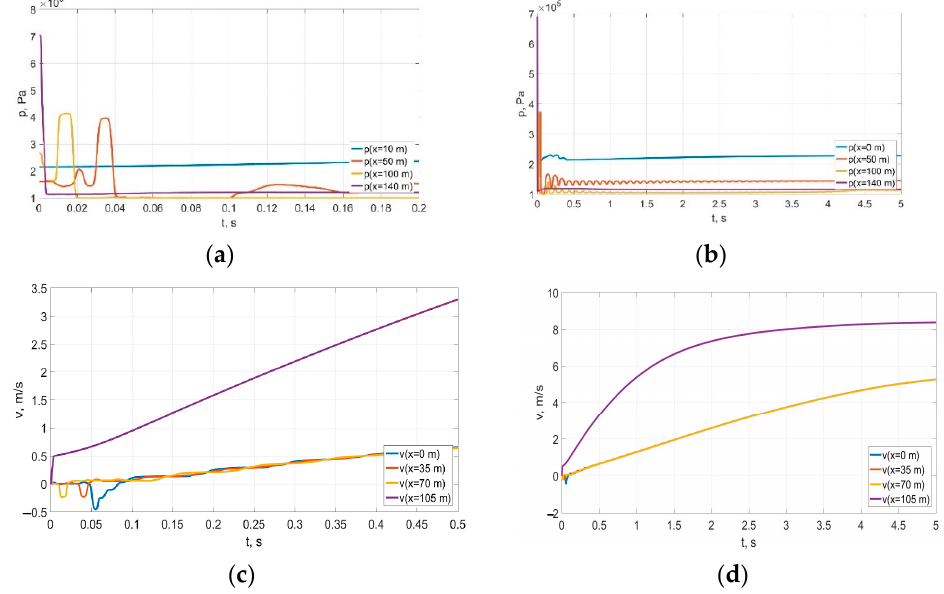
Figure 9. Pressure and velocity in the 1st pipeline (L1) (Table 2) of the LNG transportation system. Note: ( a ) pressure observation when the system starts working; ( b ) pressure observation during simulated solution time in the first pipeline in the LNG transportation system; ( c ) velocity observation when the system starts working; ( d ) velocity observation during simulated solution time in the first pipeline in the LNG transportation system.